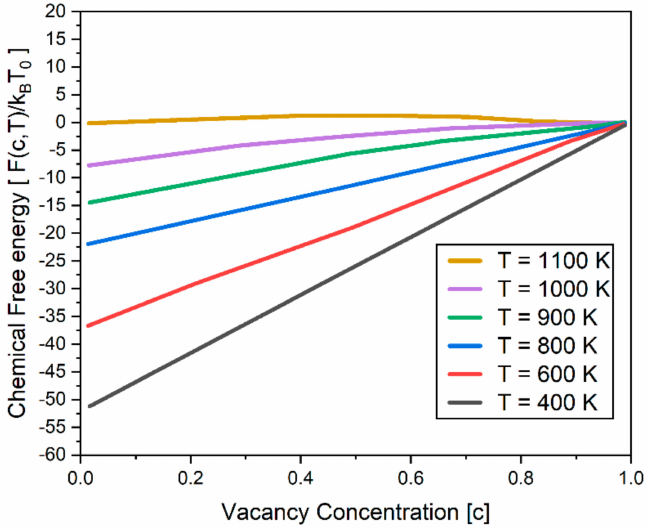
Figure 4. Chemical free energy used in the simulation. T 0 = 1100 K is taken as the reference state where the free energies of void and matrix phases are zero. Table 2. The coefficient f i ( i = 0,1,2,3,4) in Equation